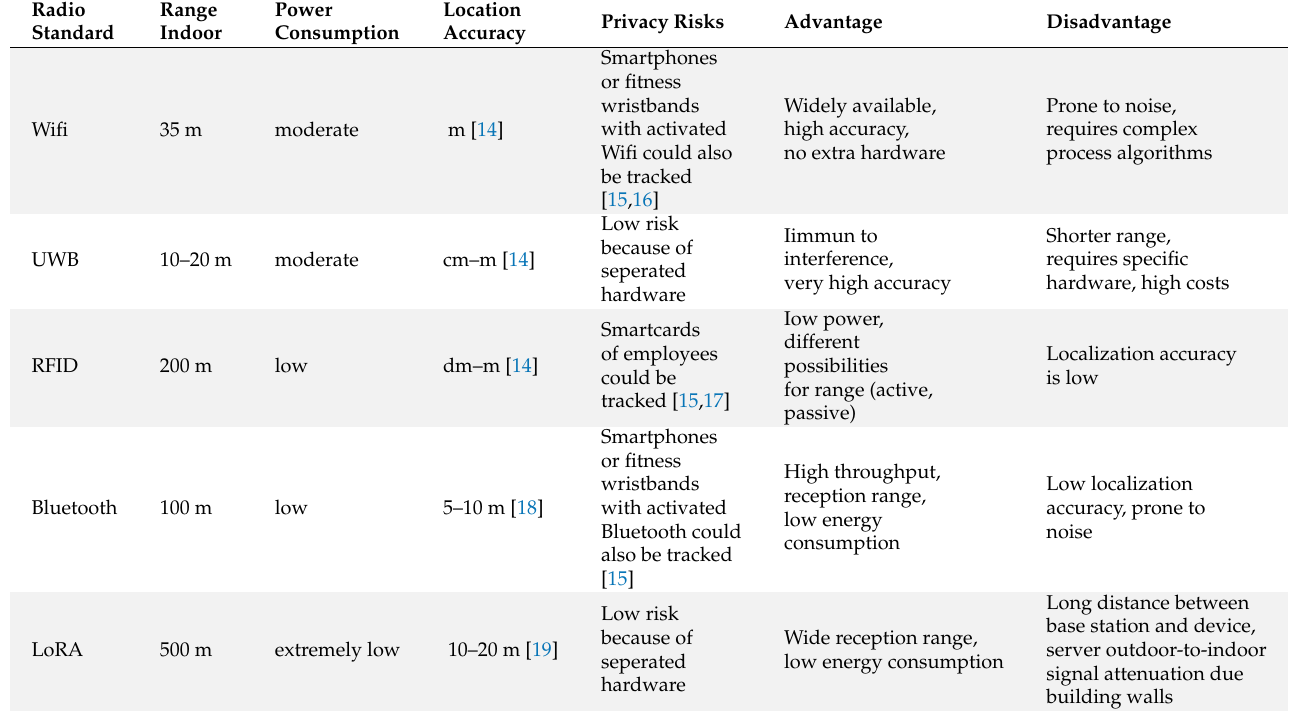
Table 1. Overview of common IPS technologies according to Zafari [13] (valid for all entries without additional reference). Radio Range Standard